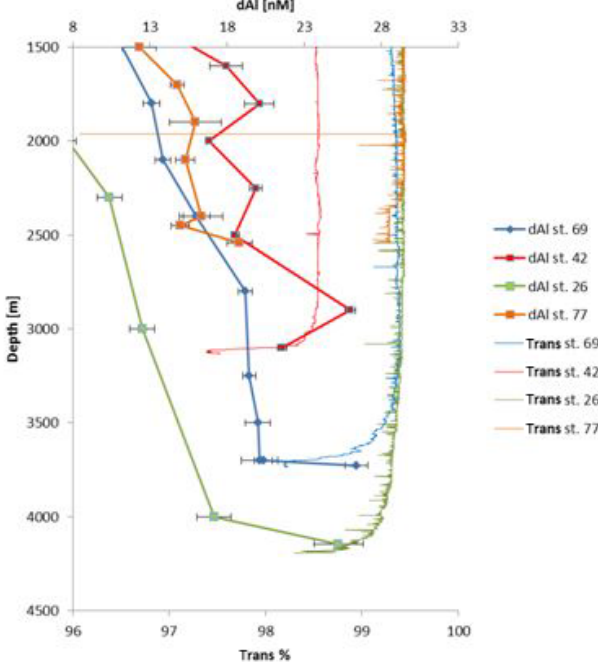
Figure 9. Dissolved Al (nM) and beam transmissometer (%) pro- files for stations 26, 42, 69, and